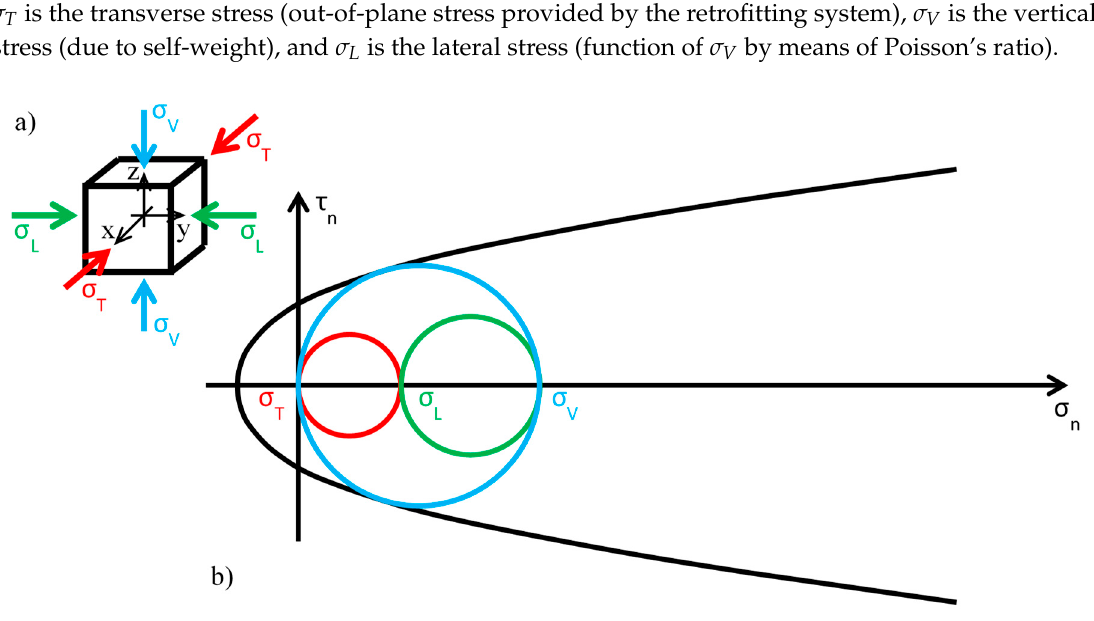
Figure 15. Stress analysis in the Mohr/Coulomb plane: ( a ) stresses acting on the infinitesimal volume of the masonry wall; ( b ) limit condition in the plane of Mohr/Coulomb before the application of the retrofitting system.